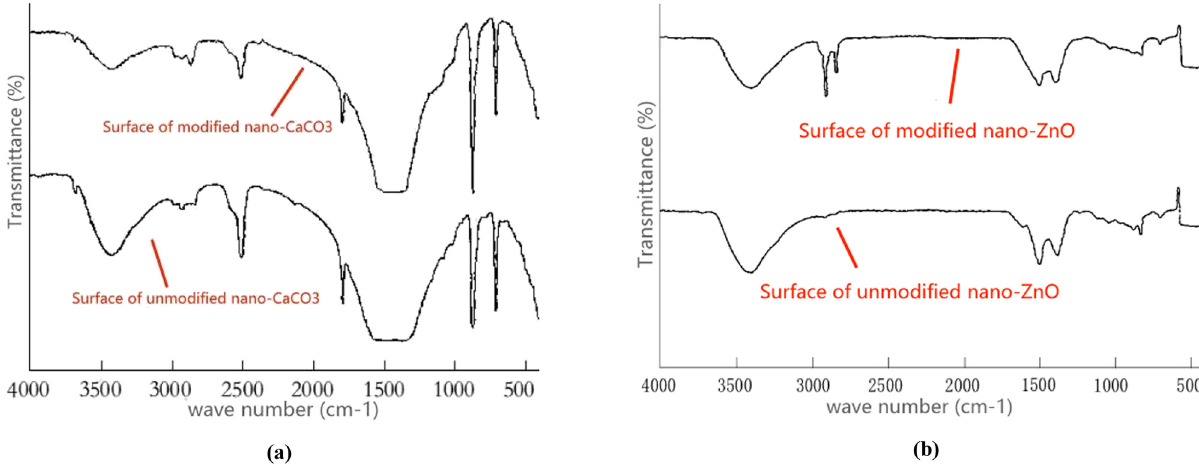
Figure 9: Infrared spectra of modi fi cation e ff ect of nanomaterials: ( a ) IR spectra before and after surface modi fi cation of nano - CaCO 3 and ( b ) IR spectra before and after surface modi fi cation of nano - ZnO.